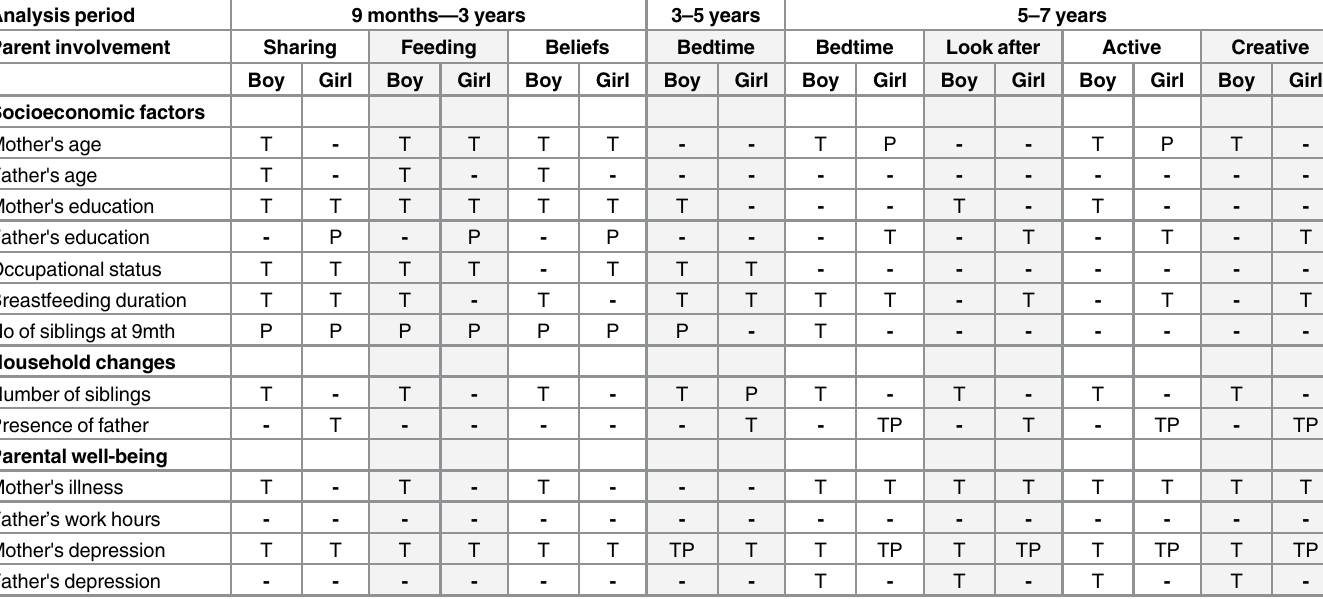
Table 3. Confounders included in adjusted statistical